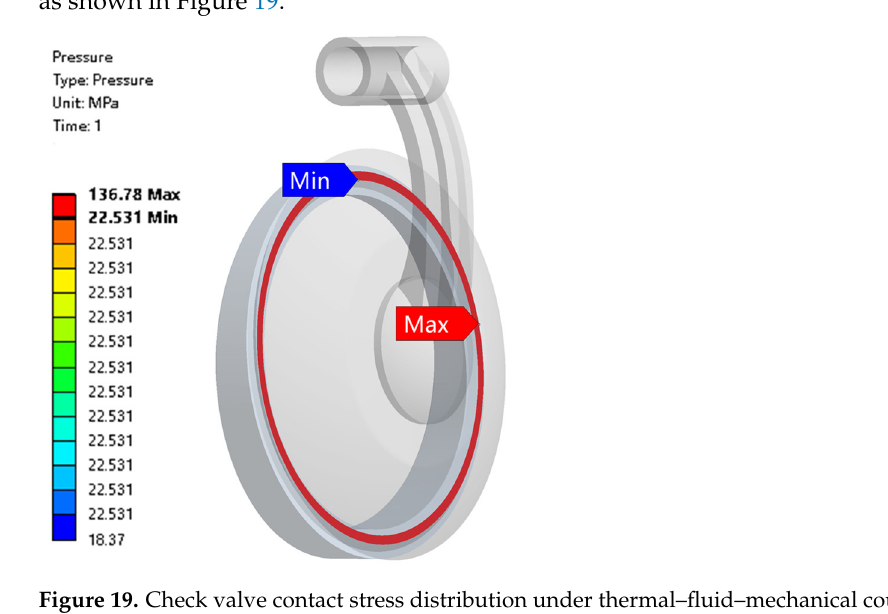
Figure 19. Check valve contact stress distribution under thermal–fluid–mechanical coupling.